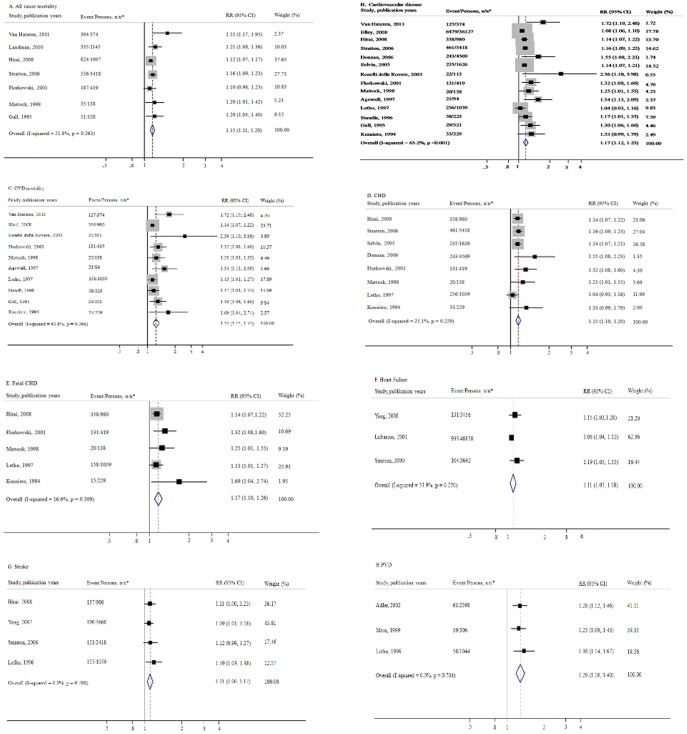
Forest plot of relative risks (RRs) and 95% confidence intervals (CIs) for the association between glycosylated hemoglobin and the main study outcomes risks in type 2 diabetes.CVD: cadiovascular diseases; CHD: conoary heart disease; PAD: peripheral arterial disease.